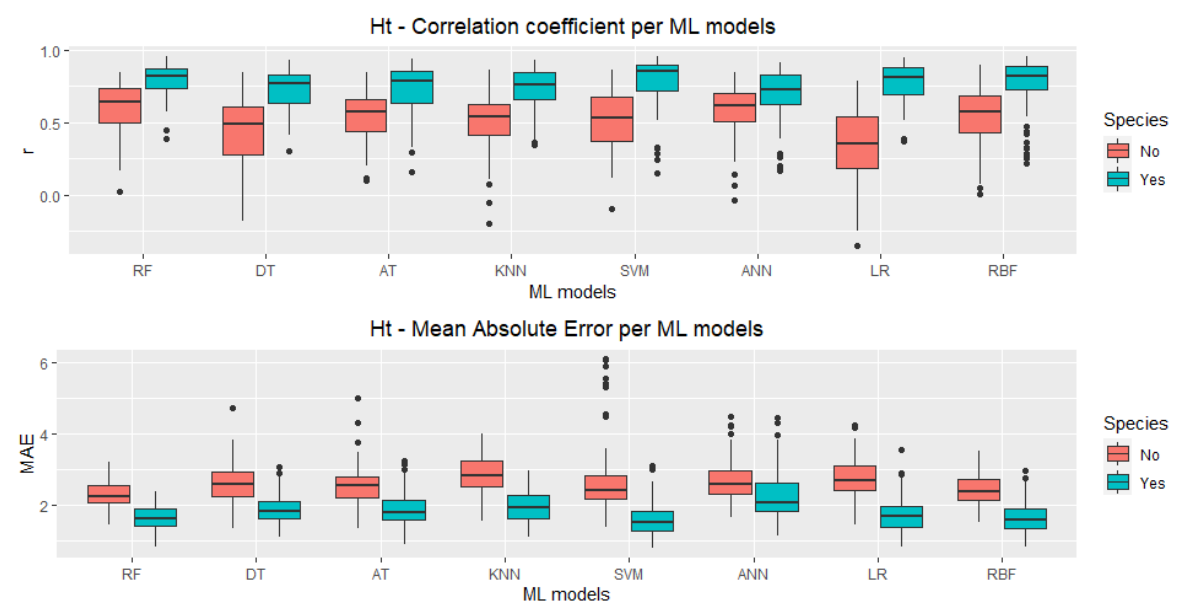
Figure 4. Boxplots for Pearson’s correlation coefficient ( r ) and Ht-mean absolute error (MAE) using all VIs, for these machine learning models: Random Forest (RF), REP Tree (DT), Alternating Model Tree (AT), K-Nearest Neighbours (KNN), Support Vector Machine (SVM), Artificial Neural Networks (ANN), Linear Regression (LR) and Radial Basis Functions (RBF).